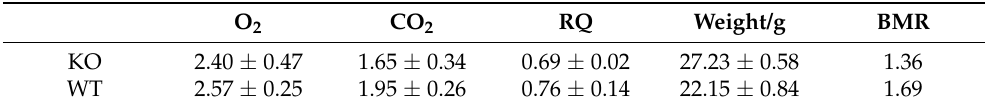
Table 2. The basic energy metabolism of Mstn -KO and WT mice. O 2